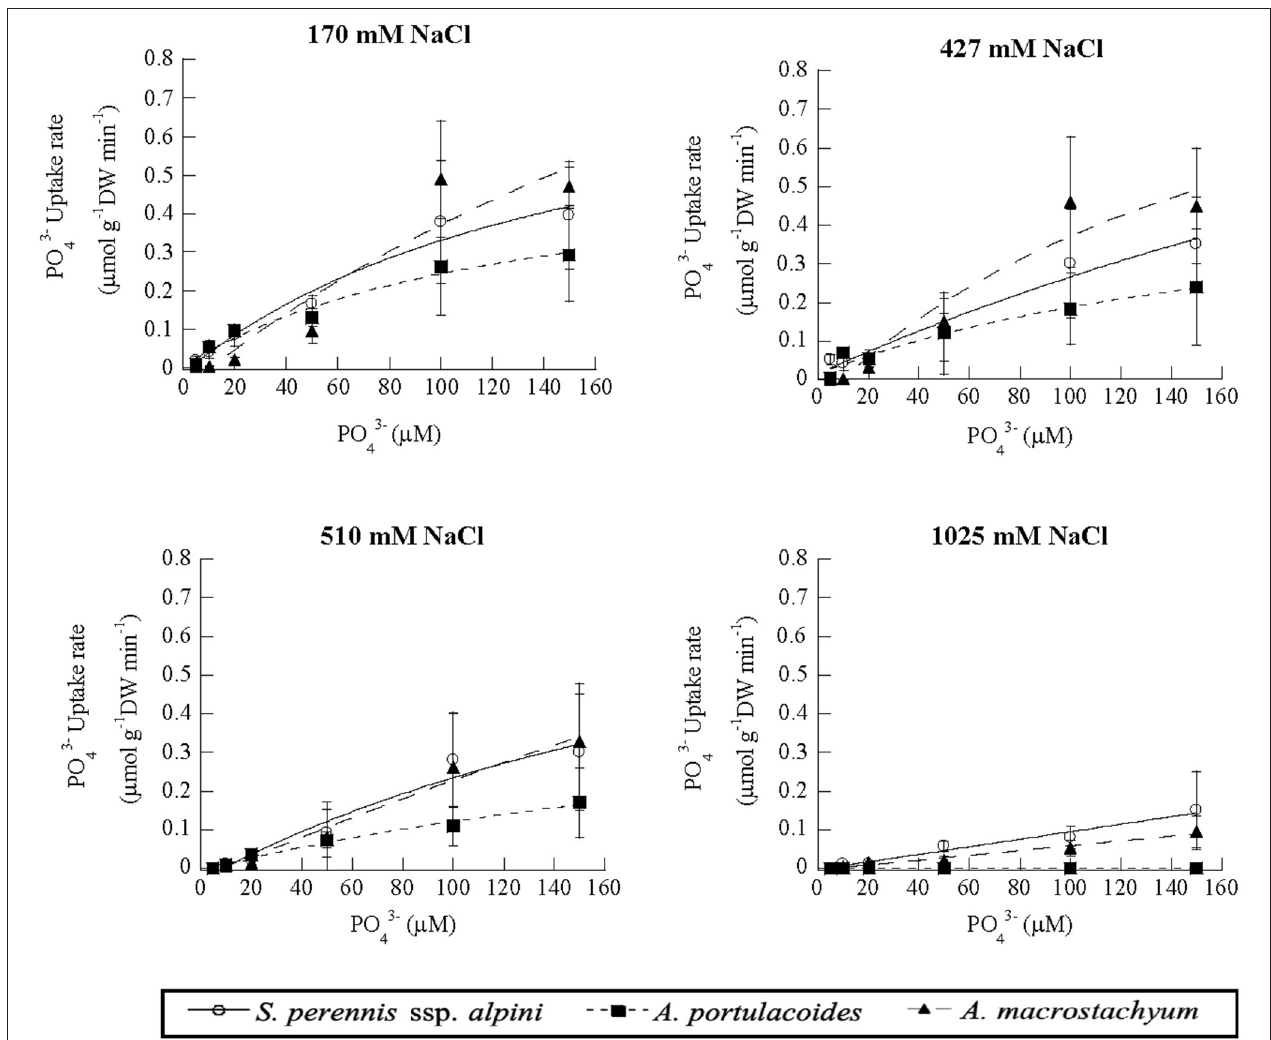
FIGURE 8 | Uptake kinetics of phosphate in S. perennis ssp. alpini, A. portulacoides and A. macrostachyum at different salinities (170, 427, 510, and 1,025mM NaCl). Bars represent standard deviations ( n = 4).